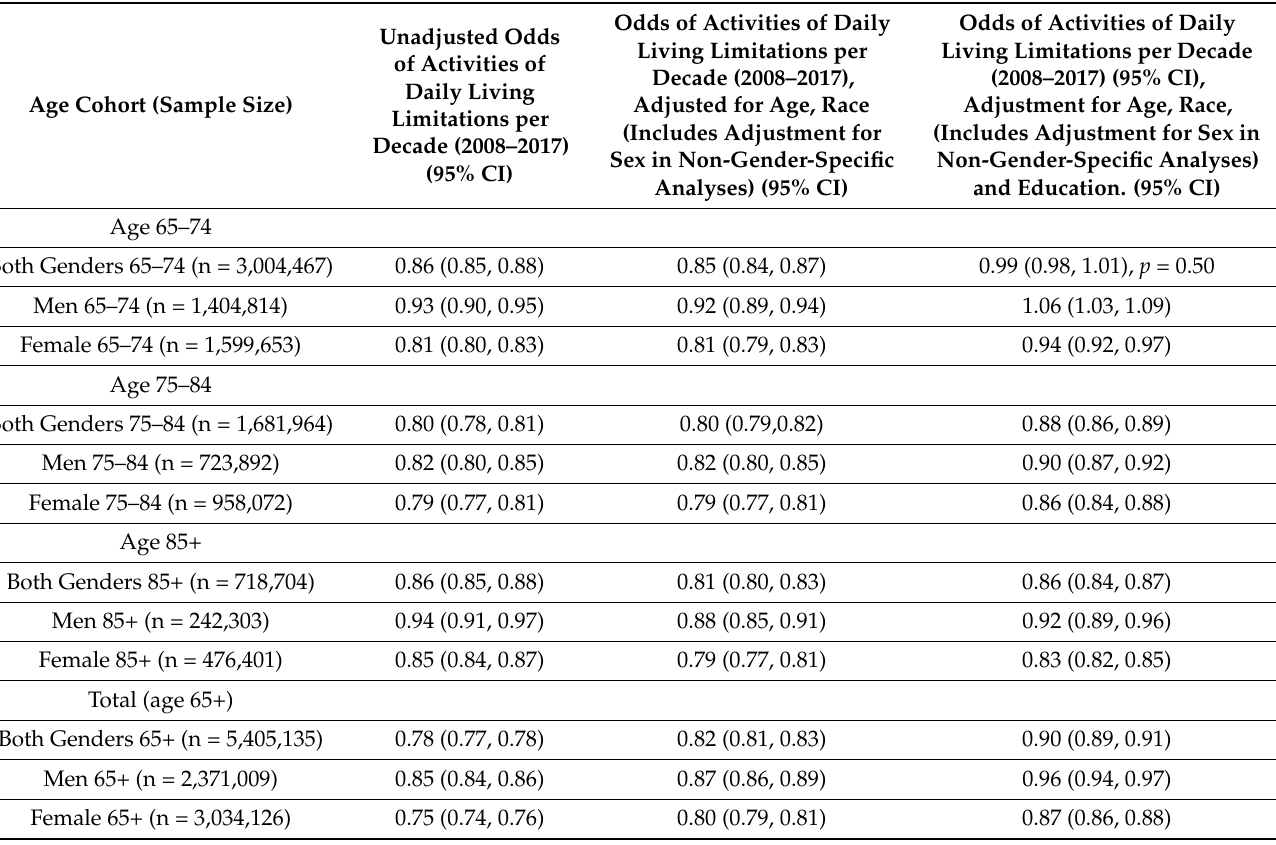
Table 2. Temporal trends in the odds of activities of daily living (ADL 1 ) limitations per decade. Odds and 95% confidence intervals ( p < 0.001, unless otherwise indicated). Source: American Community Surveys annual data from 2008–2017 (n =